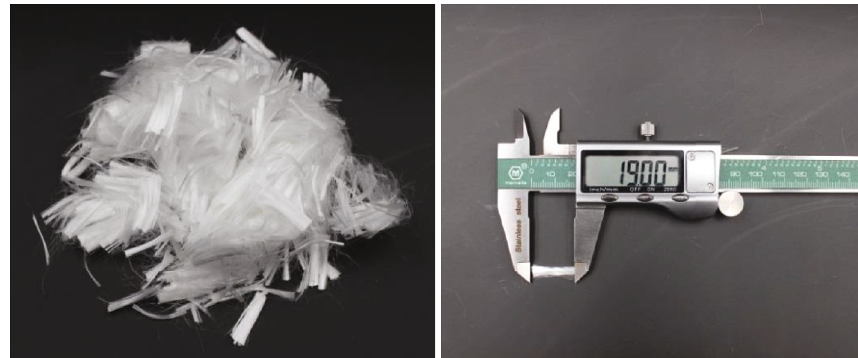
Figure 2: PPF in the experiment.